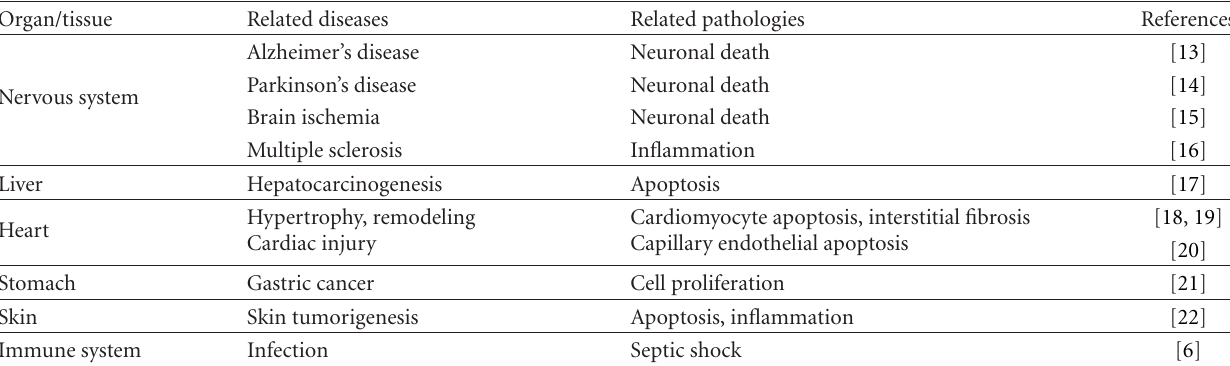
Table 1: ASK1-related diseases and